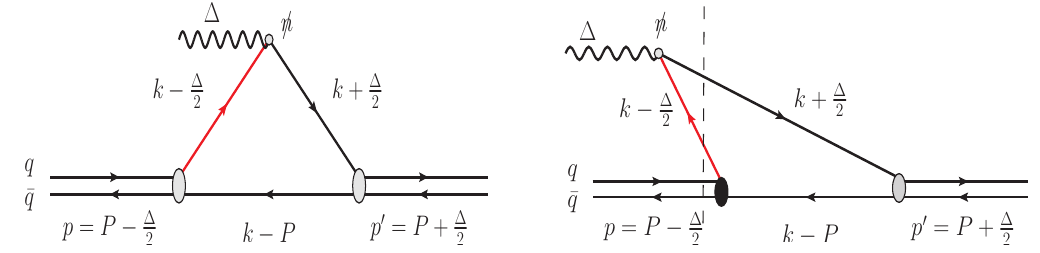
Figure 1: GPDs of the ρ meson. (a) Direct Feynman diagram contributed to the GPDs by the stuck quark ( q ) in the valence region, and (b) the stuck u quark in the non-valence